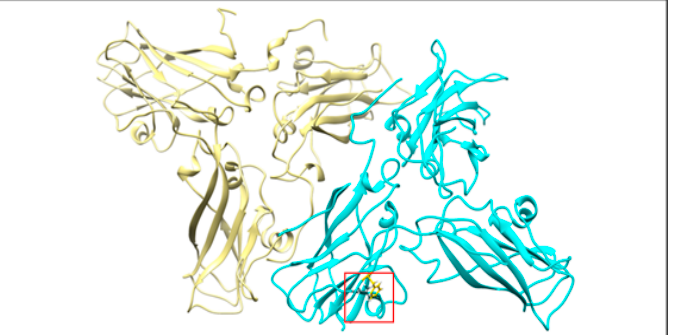
Figure 9. Computational model of two wild-type BMV capsid protein trimers. One trimer in yellow, second in cyan. The red square shows the place of interaction between two amino acid residues on two neighboring chains—the target for our mutation.